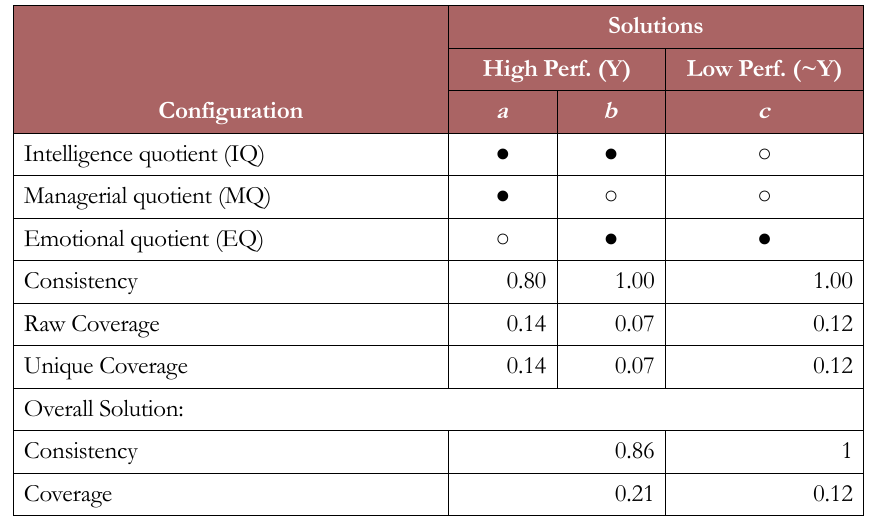
Table 9. The Leadership Configuration Table for Overall Datasets